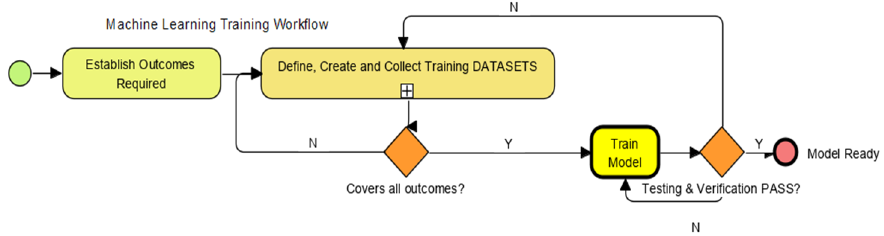
Figure 8. Machine Learning Training Workflow.